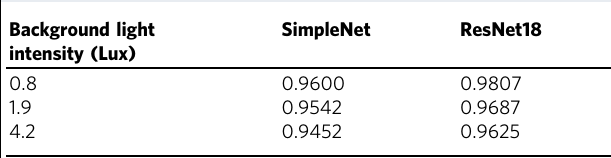
Table 2 Non-line-of-sight (NLOS) recognition accuracies using SimpleNet and ResNet18 under a homogeneous ambient